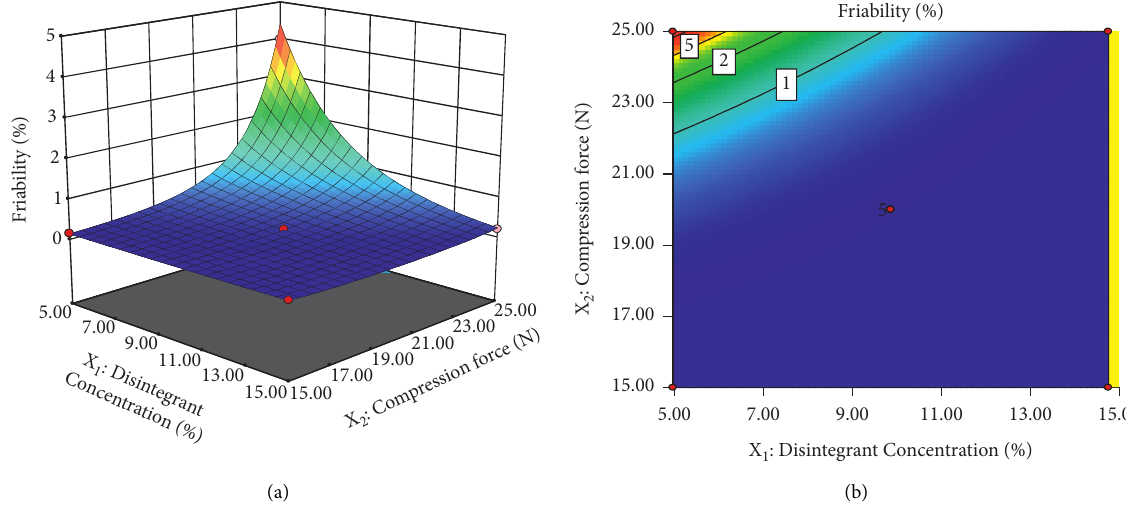
Figure 3: Surface response (a) and contour plot (b) of friability as a function of compression pressure and NTBISC.